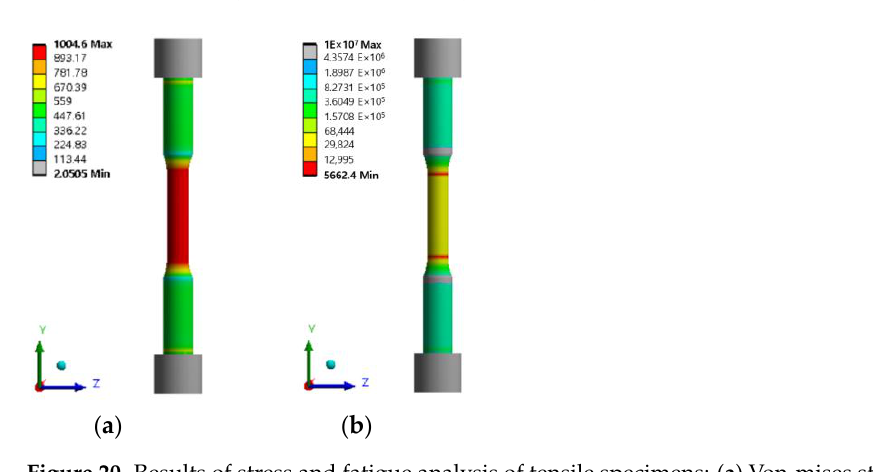
Figure 20. Results of stress and fatigue analysis of tensile specimens: ( a ) Von-mises stress of tensile specimens; ( b ) Fatigue analysis of tensile specimens. Table 8. Comparison of fatigue test specimens and analysis results.